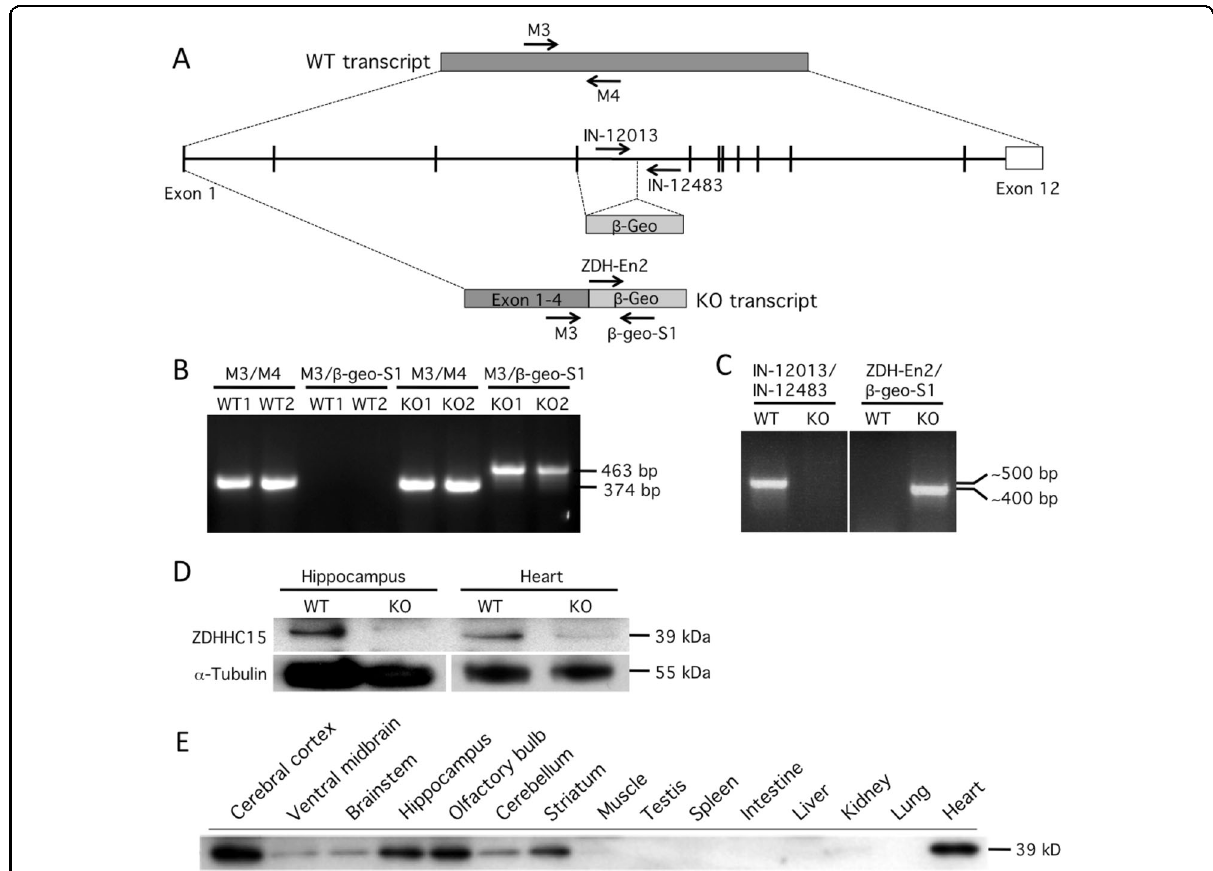
Fig. 1 Generation and characterization of zdhhc15 -KO mice. A Zdhhc15 -KO mice were generated by standard microinjection using an ES cell line containing a gene-trap in the zdhhc15 gene from the Wellcome Trust Sanger Institute, Cambridge, UK. B Con fi rmation of insertion of the gene-trap into the zdhhc15 transcript in the ES cells was performed by standard RT-PCR using the primers, M3, M4, and β -geo-S1. M3 and M4 ampli fi ed the shared region of zdhhc15 transcript; M3 and β -geo-S1 detected the gene-trapped transcript. C Genotyping of zdhhc15 -KO mice was carried out using the primers IN-12013-F (forward) and IN-12483-R (reverse) for the WT allele (~500 bp), and ZDH-En2-F (forward) and B-geo-S1-R (reverse) for amplifying the KO allele (~400 bp). D Immunoblot of ZDHHC15 using a custom rabbit antibody against mouse sequence peptide: YTDKERYKNEERPEC (GenScript Corporation) showing almost non-detectable levels of protein in hippocampus and heart of the zdhhc15 -KO mice. E Tissue expression pro fi le of ZDHHC15 in a WT mouse. Immunoblot using the same custom-rabbit antibody against ZDHHC15 (GenScript Coorporation) identi fi ed a 39 kD band corresponding to ZDHHC15 protein that was highly expressed in brain regions and heart of WT